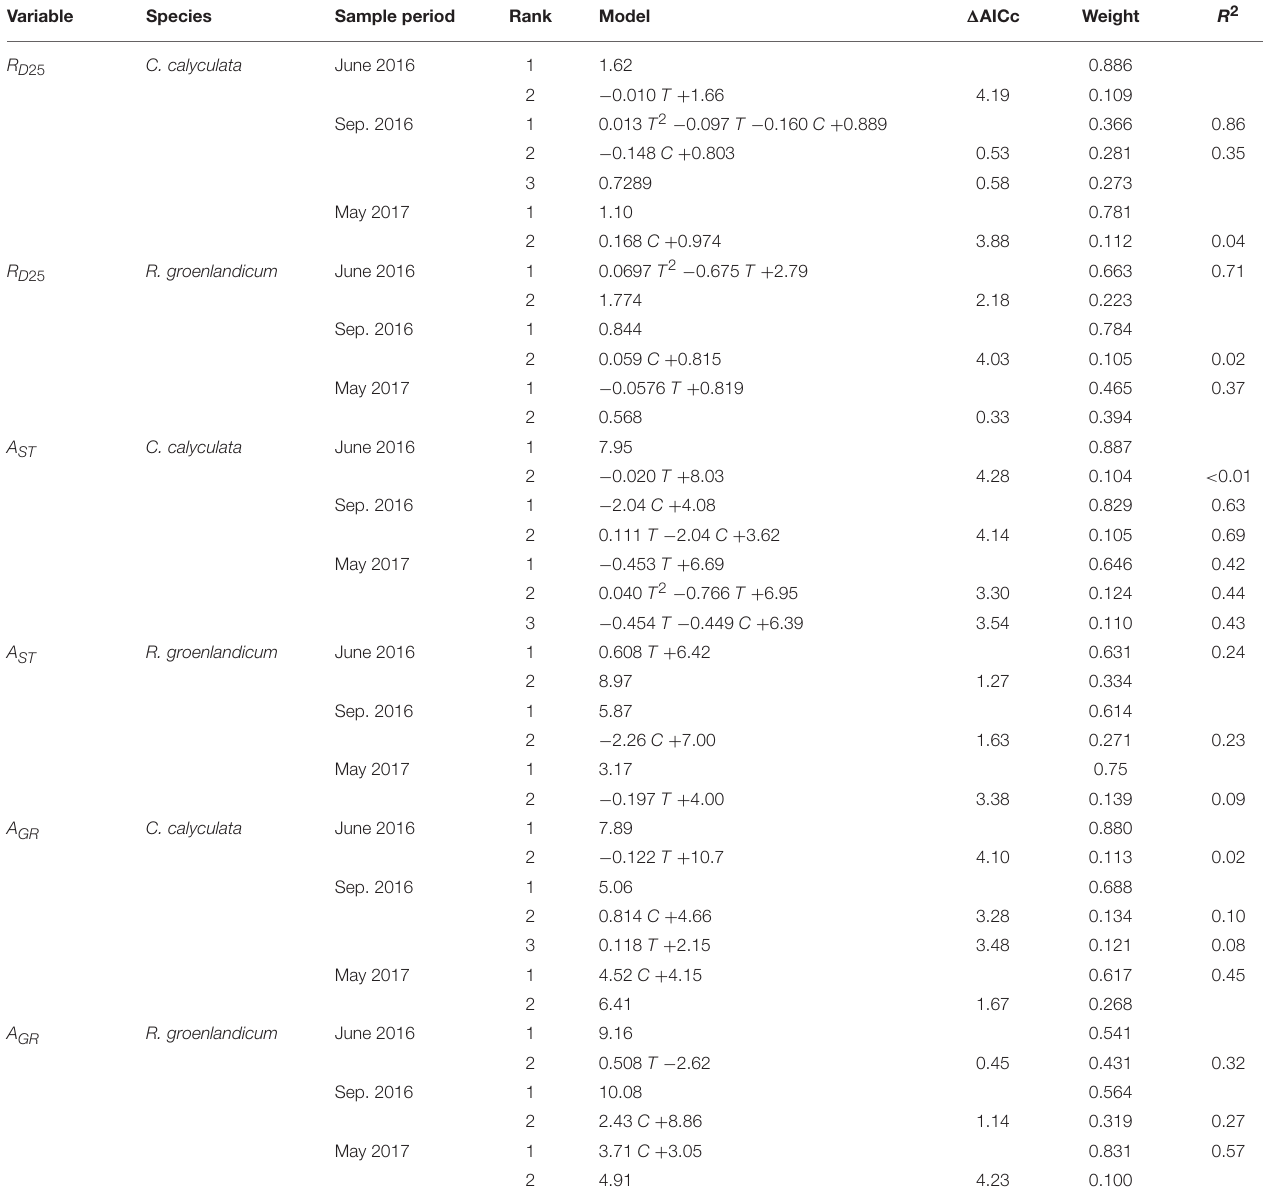
TABLE 1 | Top two models for each gas exchange variable, species, and measurement period as evaluated by Akaike Information Criterion corrected for sample size (AICc) for the independent variables temperature ( T , Celsius) and elevated [CO 2 ] treatment ( C , 0 = ambient [CO 2 ], 1 = + 500 ppm). Variable Species Sample period Rank Model 1